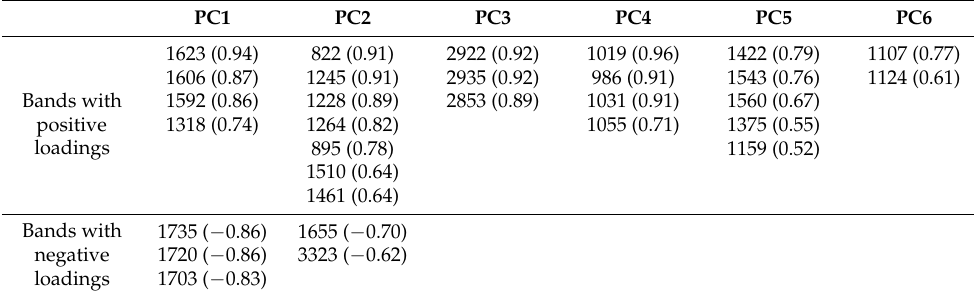
Table 3. List of FTIR bands (with loading values) in relation to the extracted PCA